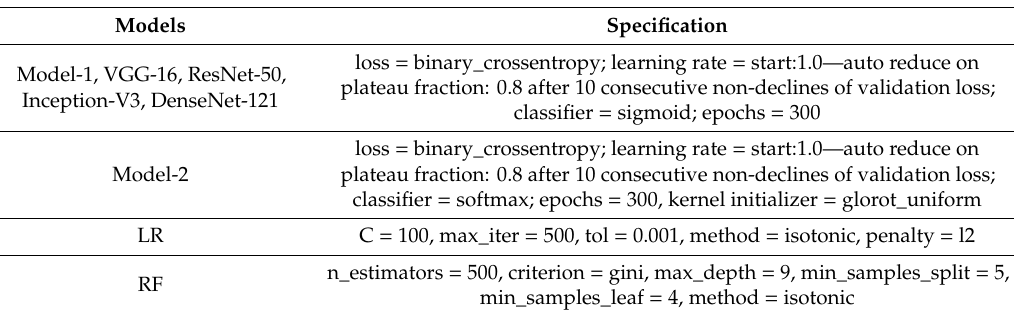
Figure 8. Flow diagram for DL and ML classification. Handcrafted and non-handcrafted colour texture descriptors were extracted for EML classification. Table 3. Hyperparameters Tuning for DL and ML classifiers.